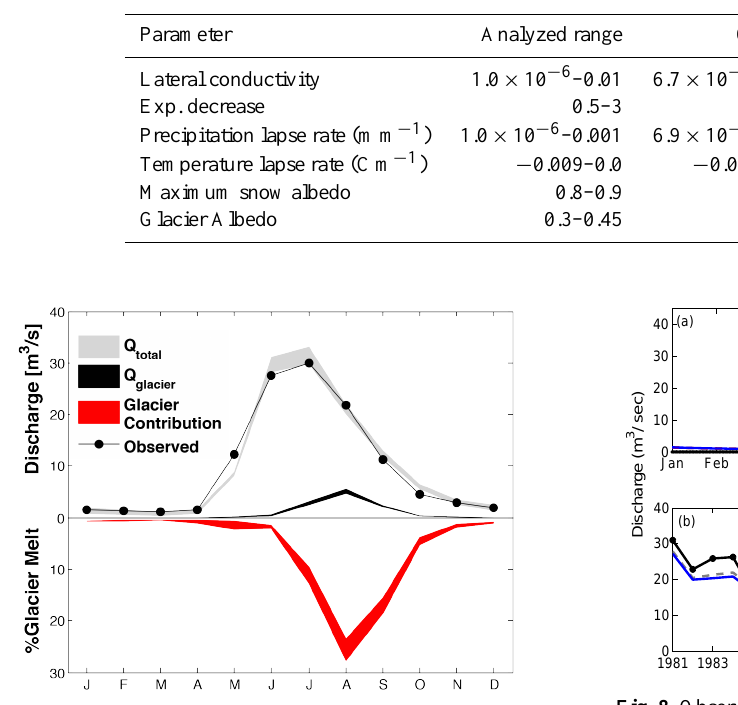
Table 1. Calibrated DHSVM parameters.